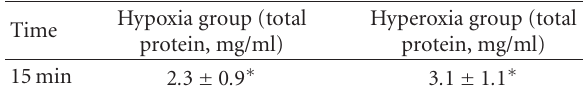
There was no di ff erence in protein content between hypoxia and hyperoxia group. However, these levels were significantly lower than in the meconium group ( P < . 05) (see above in Table 2(a)) and higher than the saline group.